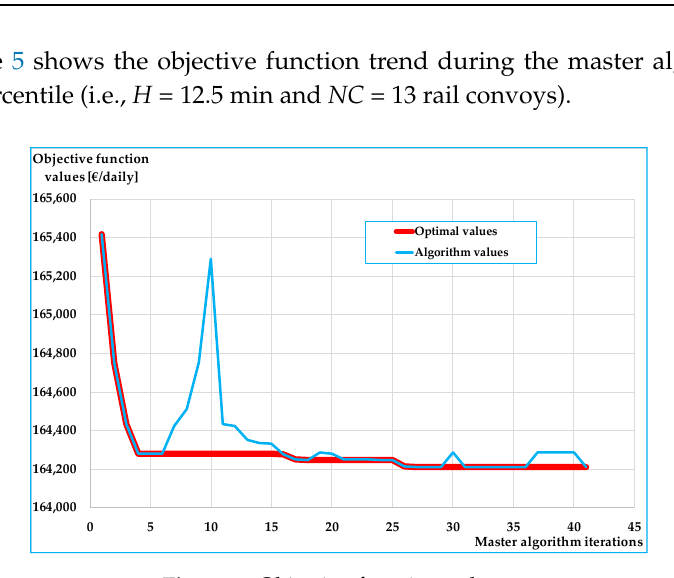
Figure 5. Objective function values.